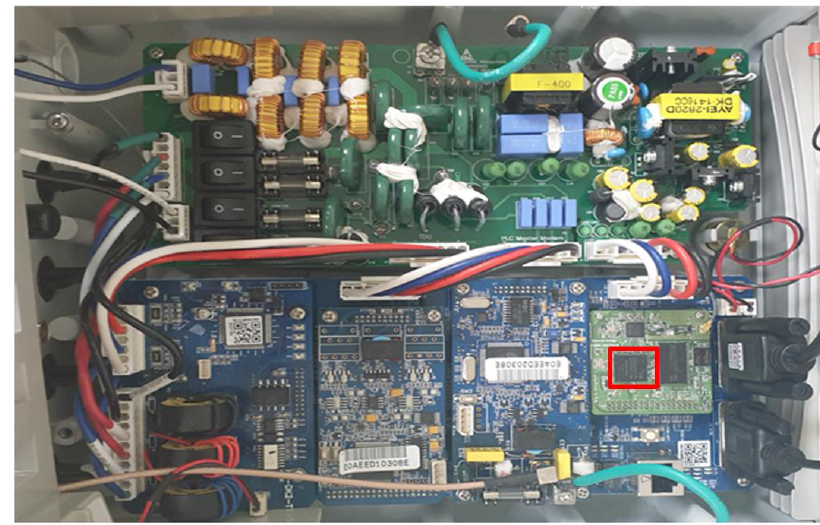
Figure 10. PCB of